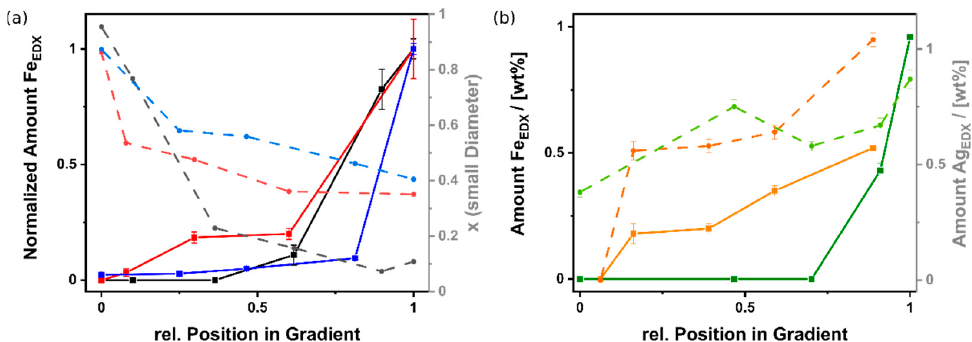
Figure 6. ( a ) Correlation of the Fe content (solid lines) and the area occupied by small pores (segmented lines) with the relative position in the gradient in various Mag@C. Black curves: combination of PSS-38 and Mag@PSS; red curves: combination of PSS-137 and Mag@PSS; blue curves: combination of PSS-288 and Mag@PSS. EDX spectra and SEM micrographs given in Figure S12. ( b ) Correlation of the Fe content (solid lines) and Ag content (segmented lines) determined by EDX with the relative position in the gradient in various Ag/Mag@C materials with different pore sizes. Green